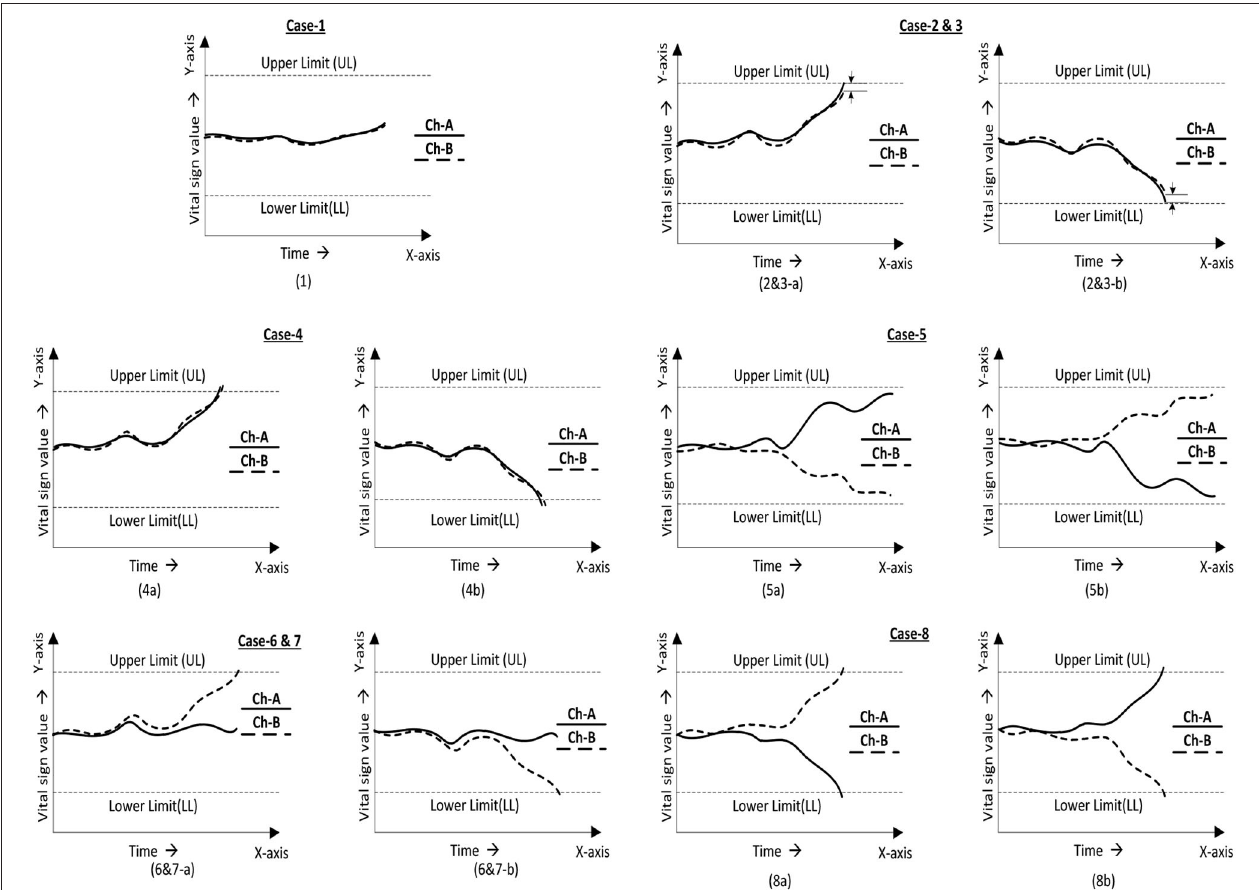
FIGURE 3 | 2oo2 voting logic cases for assessment. (1) Values are in a relationship and are in the normal range. (2 and 3) Values in relationship with one signal drift toward the limit. (4) Values in relationship with both signals drift toward the limit. (5) Values out of a relationship and in the normal range. (6 and 7) Values out of a relationship with one signal drift toward the limit. (8) Values out of a relationship with both signals drift toward limits.